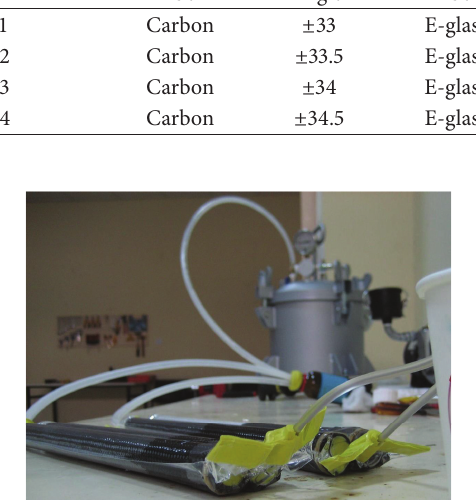
Figure 2: VARTM specimens while resin feeding is done by vacuum.